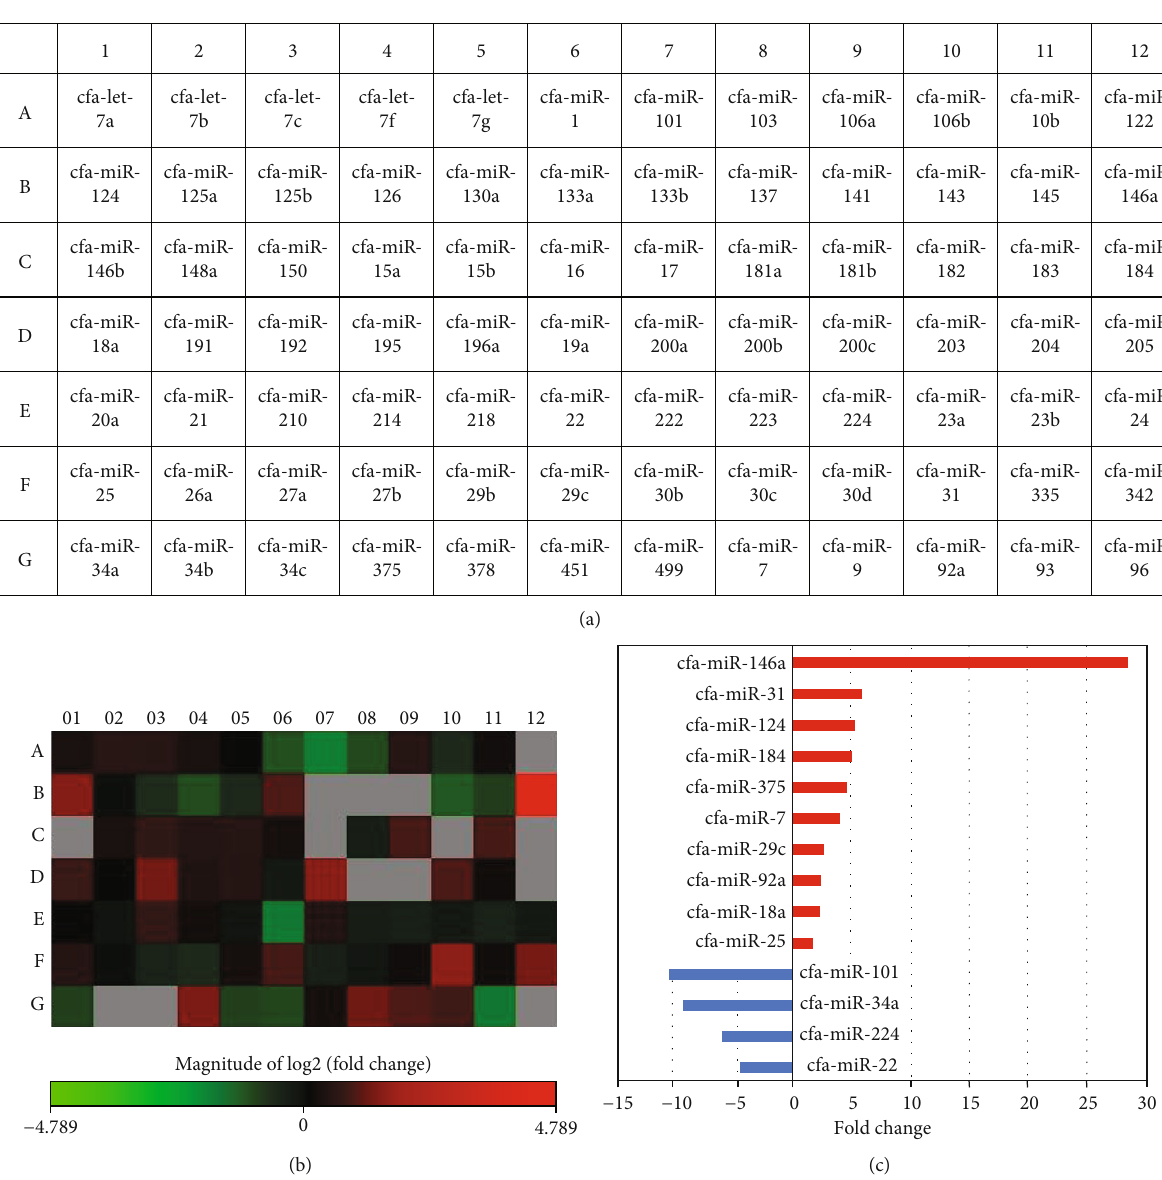
Figure 2: Di ff erential expression of microRNAs in naive and primed cADSC-EVs. (a) Layout for Qiagen ’ s canine miScript miRNA PCR Array. (b) Heatmap of microRNA expression between naive and primed cADSC-EVs. Red an increase and green/black indicate a decrease in relative expression in primed cADSC-EVs ( n = 3 per group). Gray microRNAs represent not detected. (c) Signi fi cant di ff erences in expression levels of microRNAs. Red bar indicates an increase in primed cADSC-EVs, and blue bar indicates an increase in naive enriched fraction of exosomes (Figure 1(b)).